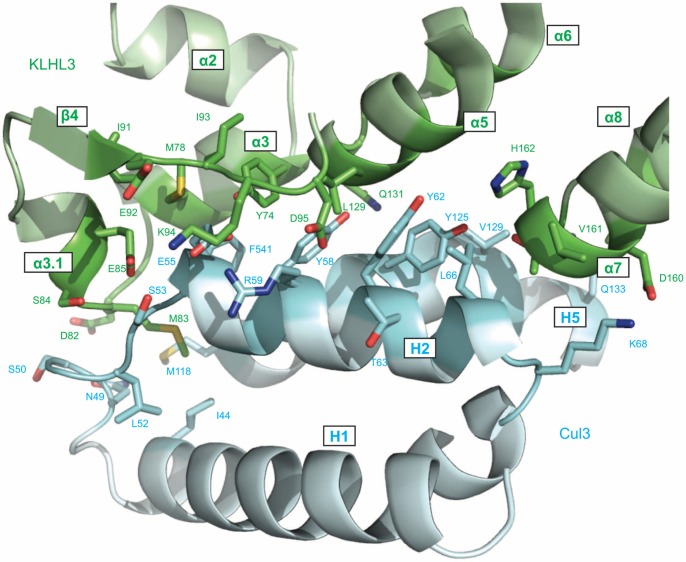
Details of the KLHL3BTB-BACK/Cul3NTD interface.The side chains of the residues at the protein-protein interface are indicated.